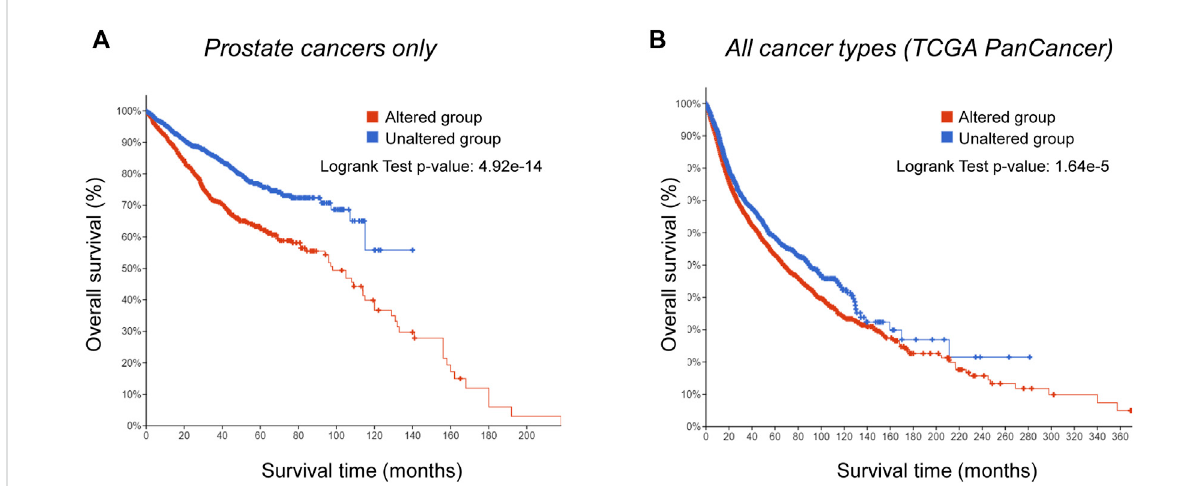
FIGURE 3 Genetic alterations in targets of PC-3-speci fi c nuclear-size rectifying compounds [NSRs, predicted in Tollis et al. (2022)] correlate with worse prognosis in prostate cancer speci fi cally. (A) Kaplan-Meier analysis of survival of prostate cancer patients with alterations in targets of PC-3-speci fi c NSRs(red),andpatientswithoutalterations inthesamegenes(blue).Differenceinsurvivalbetweenthetwogroupsisstatisticallysigni fi cant(logrank test p -value: 4.92*10 − 14 ). (B) Kaplan-Meier analysis of survival of patients presenting a range of cancer types (TCGA PanCancer Atlas data), with alterations in targets of PC-3-speci fi c NSRs (red), and patients without alterations in the same genes (blue). Difference in survival between the two groups is more subtle than in prostate cancer, but still statistically signi fi cant (log rank test p -value: 1.64*10 − 5